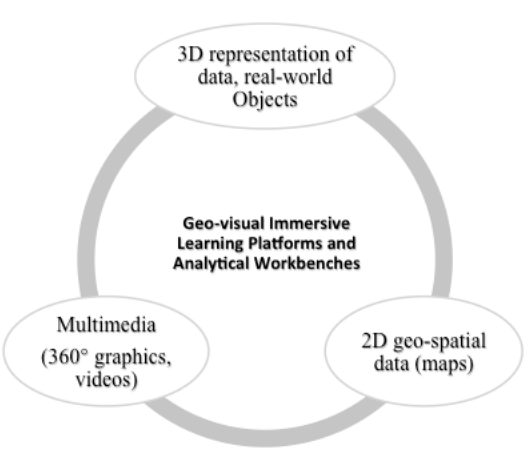
Figure 5. Our xR site experience approach dynamically linking views to enable geo-visual immersive learning platforms and analytical workbenches [adapted from (Masrur, 2017)]